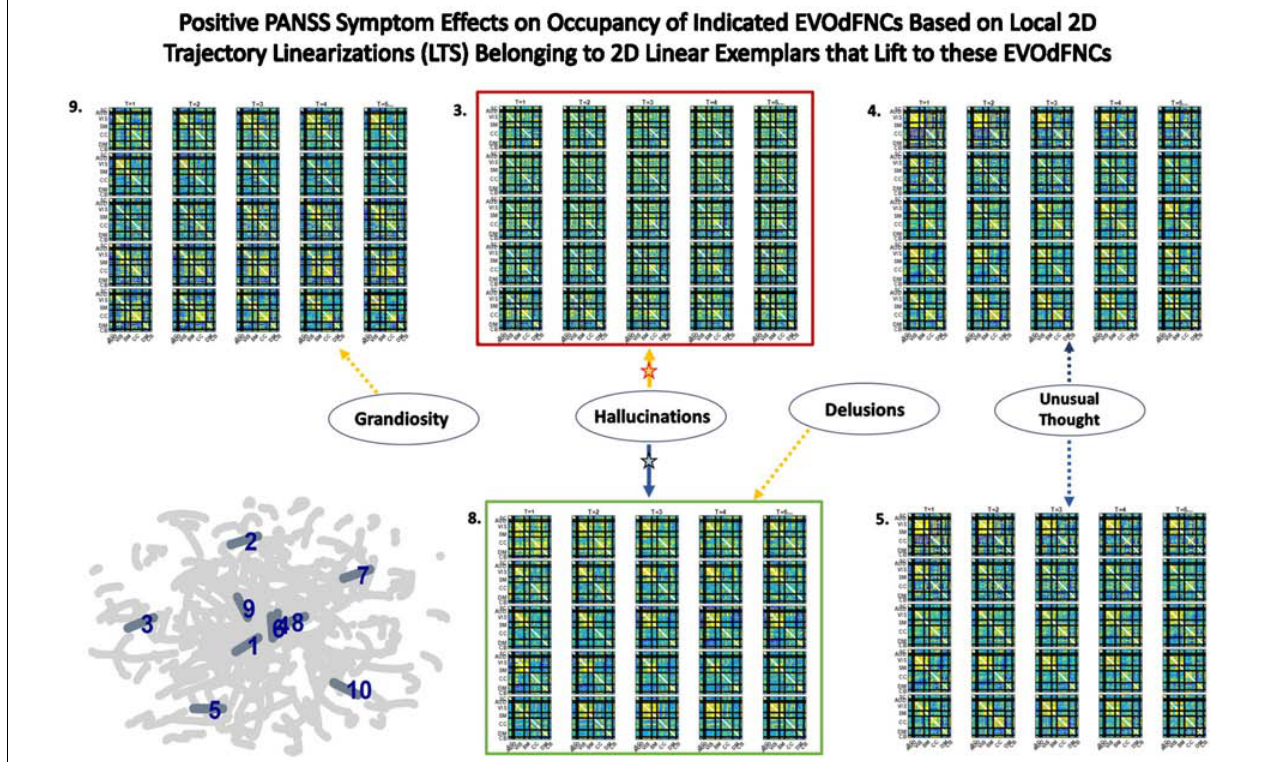
FIGURE 16 | Five of the seven positive PANSS symptoms exhibited significant relationships with membership of local 2D trajectory linearizations to clusters defining the linear trajectory exemplars that lift to the displayed EVOdFNCs. Red (respectively, green boxes) around EVOdFNCs indicate positive (respectively, negative) SZ effects on their representational importance in observed high-dimensional dFNC trajectories. Yellow (respectively, blue) arrows point symptoms to EVOdFNCs with which they exhibit positive (respectively, negative) membership effects. Symptom effects are significant at the p < 0 . 025 level. The negative effect of Hallucinations with 2D exemplar #8, i.e., with EVOdFNC #8, remains significant at the p < 0 . 05 level after correction for multiple comparisons. Note that positive symptoms exhibit no significant ( p < 0.05, uncorrected) effects on the occupancy rates of the